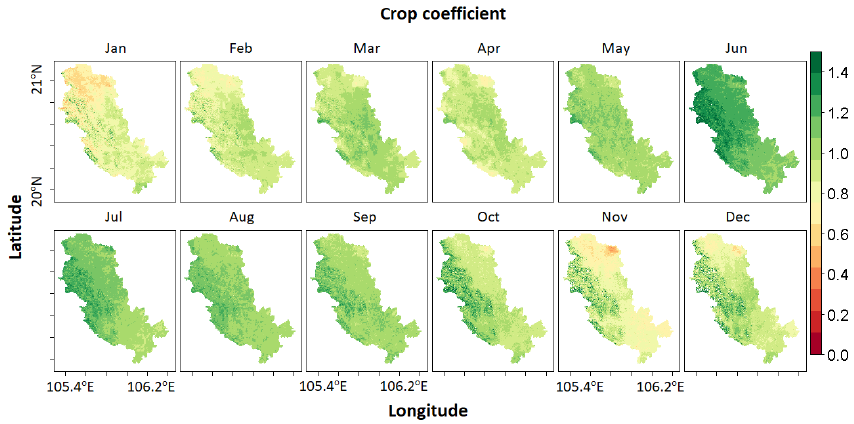
Figure 5. Monthly crop coefficient (K c ) derived from the ratio between the ensemble ET and reference ET.